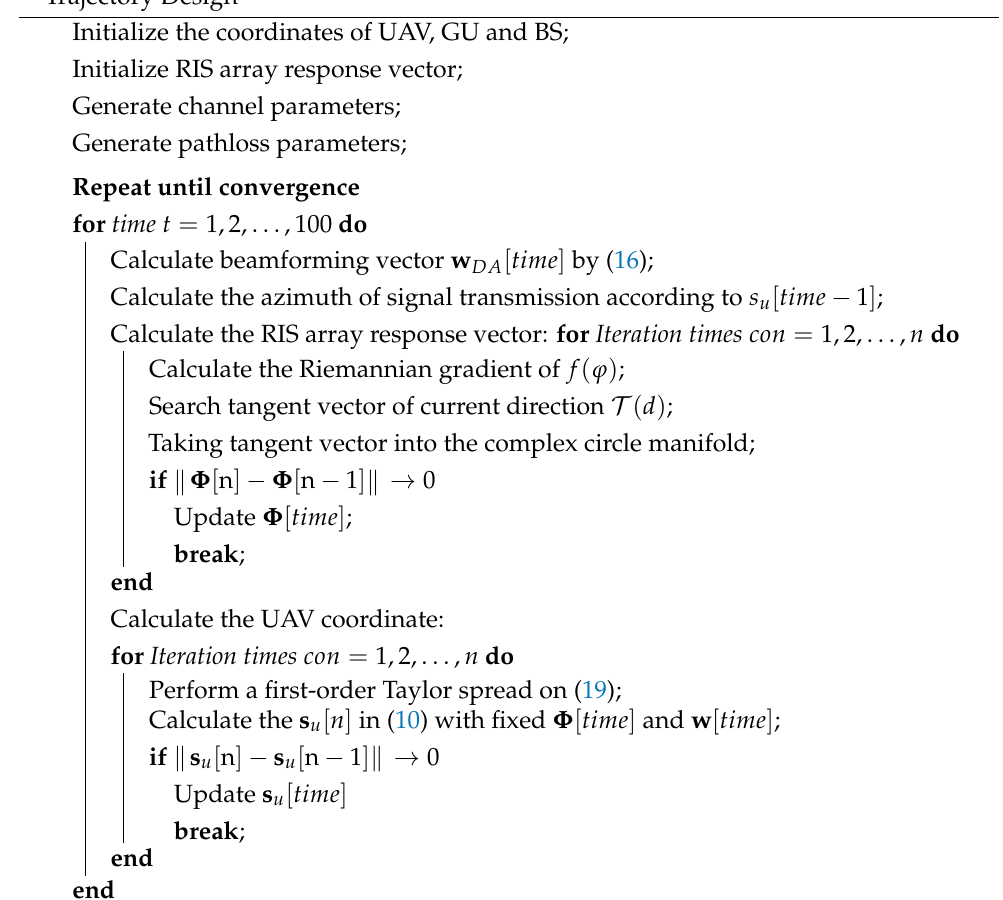
Algorithm 1 The AO Algorithm for the Power Allocation and Phase Shift and Trajectory